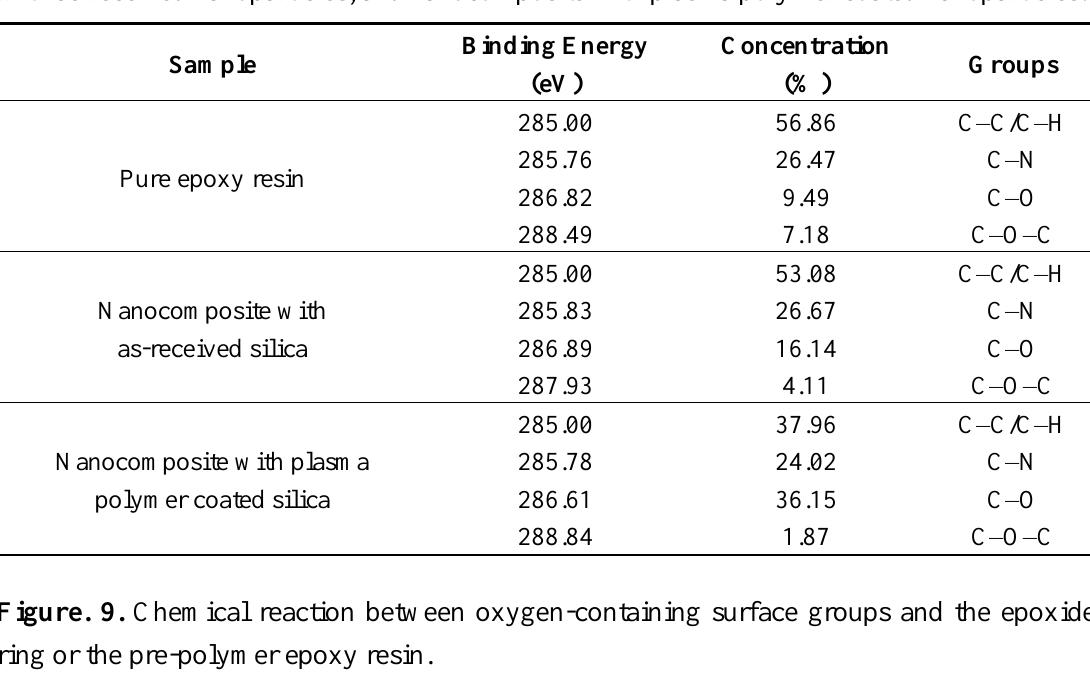
Table 2. Characteristics of the peaks in C 1s spectra for pure epoxy resin, nanocomposite with as-received nanoparticles, and nanocomposite with plasma polymer coated nanoparticles.